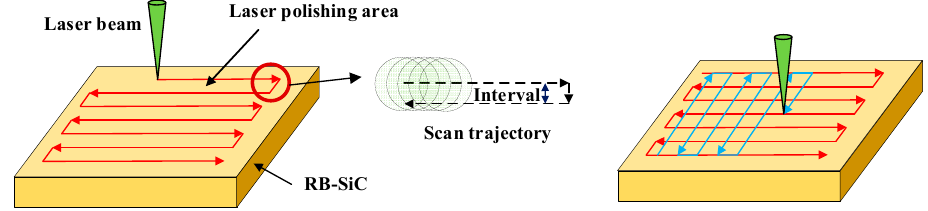
Figure 2. Simulation of surface topography after scanning with different pulse density: ( a )Low pulse